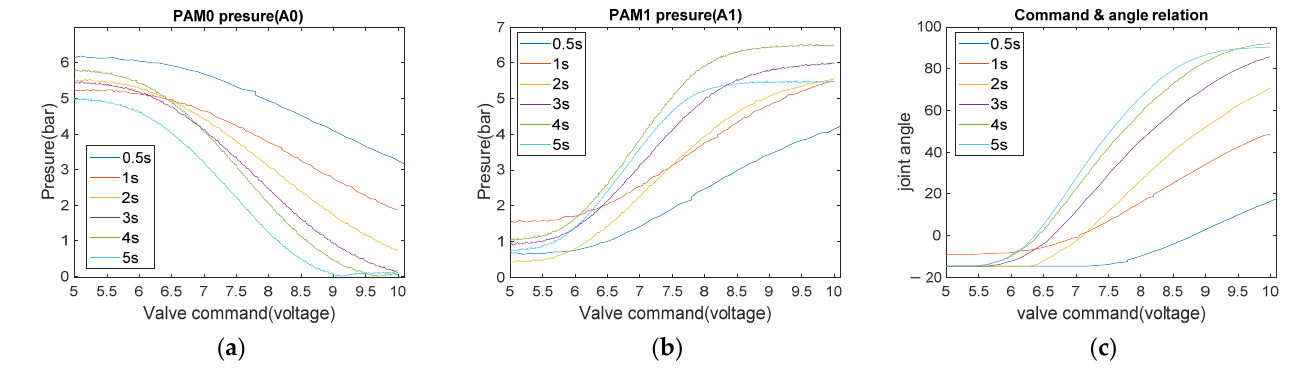
Figure 14. Forward movement system response. ( a ) PAM0 pressure changes (bar); ( b ) PAM1 pressure changes (bar); ( c ) command signals and angle relation.